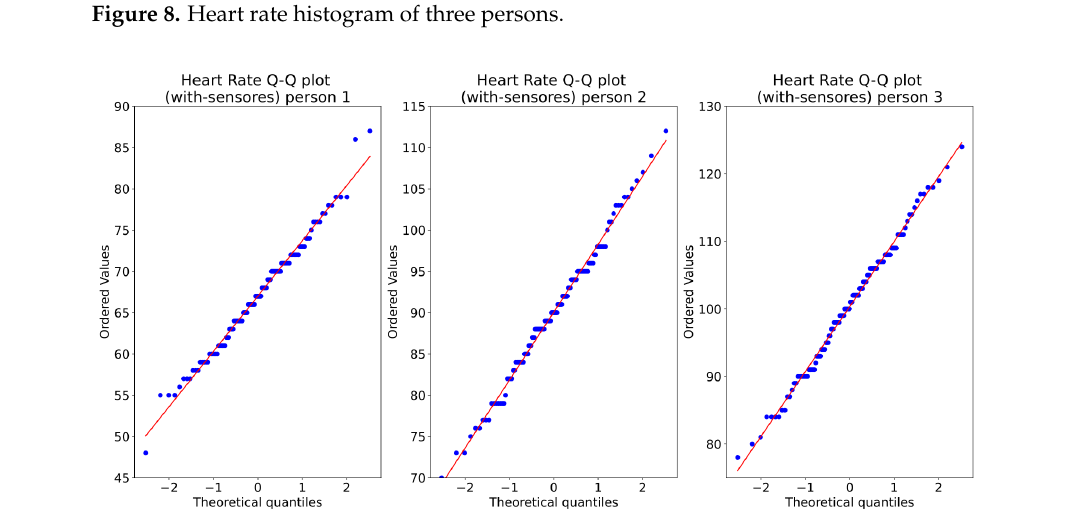
Figure 8. Heart rate histogram of three persons.